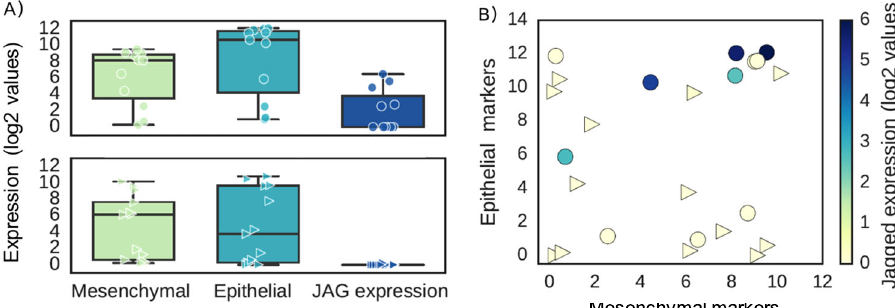
Fig. 2 Expression pattern of 13 single CTCs and 11 CTC-clusters at single-cell level. a Expression level of mesenchymal (ZEB1, ZEB2, SNAI1, SNAI2, TWIST1, VIM, CD44) and epithelial markers (CDH1, EPCAM (Epithelial cell adhesion molecule), CD24) and Jagged (JAG1, JAG2) in individual CTCs ( bottom ) and CTC clusters ( top ). b Single cells are represented based on their levels of mesenchymal markers ( x -axis) and epithelial markers ( y -axis). Color code represents the expression values of the ligand Jagged. Gene counts table was directly downloaded from GSE repository (Aceto et al.; 9 GSE 51827), and cells with less than 0.1 million reads were excluded from the analysis. Data was analyzed via Python and Jupyter Notebook web application (source code freely available at